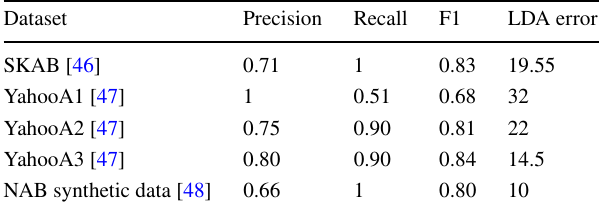
Table 7 The results of algorithm evaluation [46–48] Dataset Precision